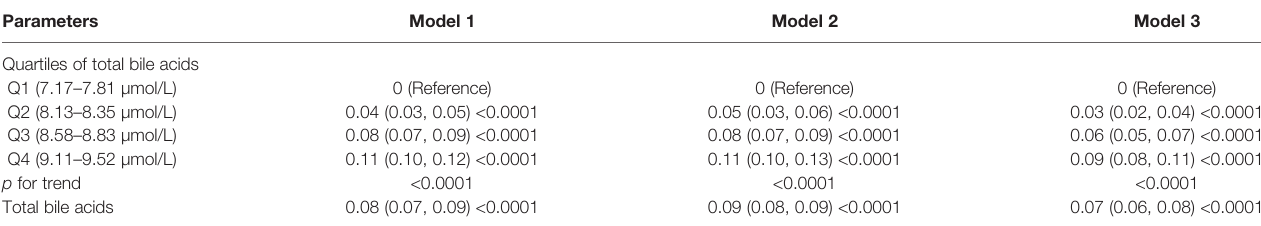
TABLE 2 | The association between TBA (µmol/L) and femoral neck BMD (g/cm 2 ).